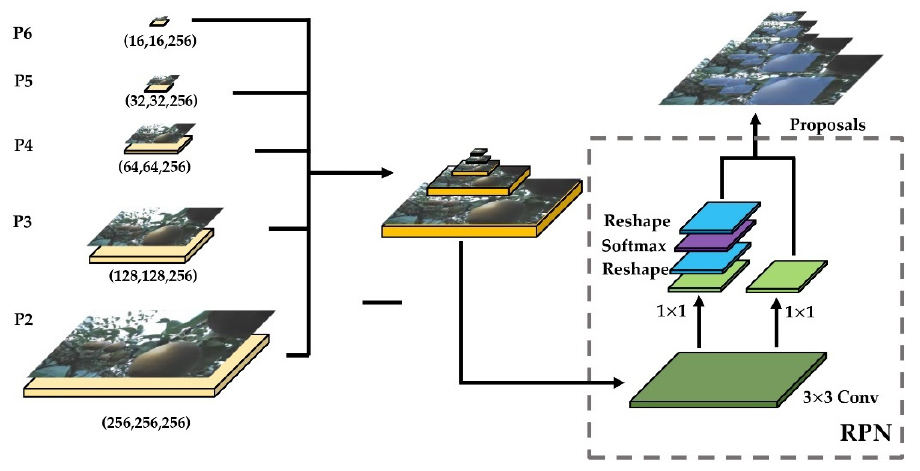
Figure 6. RPN in Mask R-CNN for extracting proposals of original pear images. The positive and negative classes for network training were established by the gen- erated anchors and 256 were selected according to intersection-over-union (IoU) [12] for training the RPN, of which, 128 positive samples (foreground) and 128 negative samples (background) were guaranteed. This step was performed to calibrate the anchor box, in addition to calculating the offset between the anchor box and the ground truth (Figure 7).